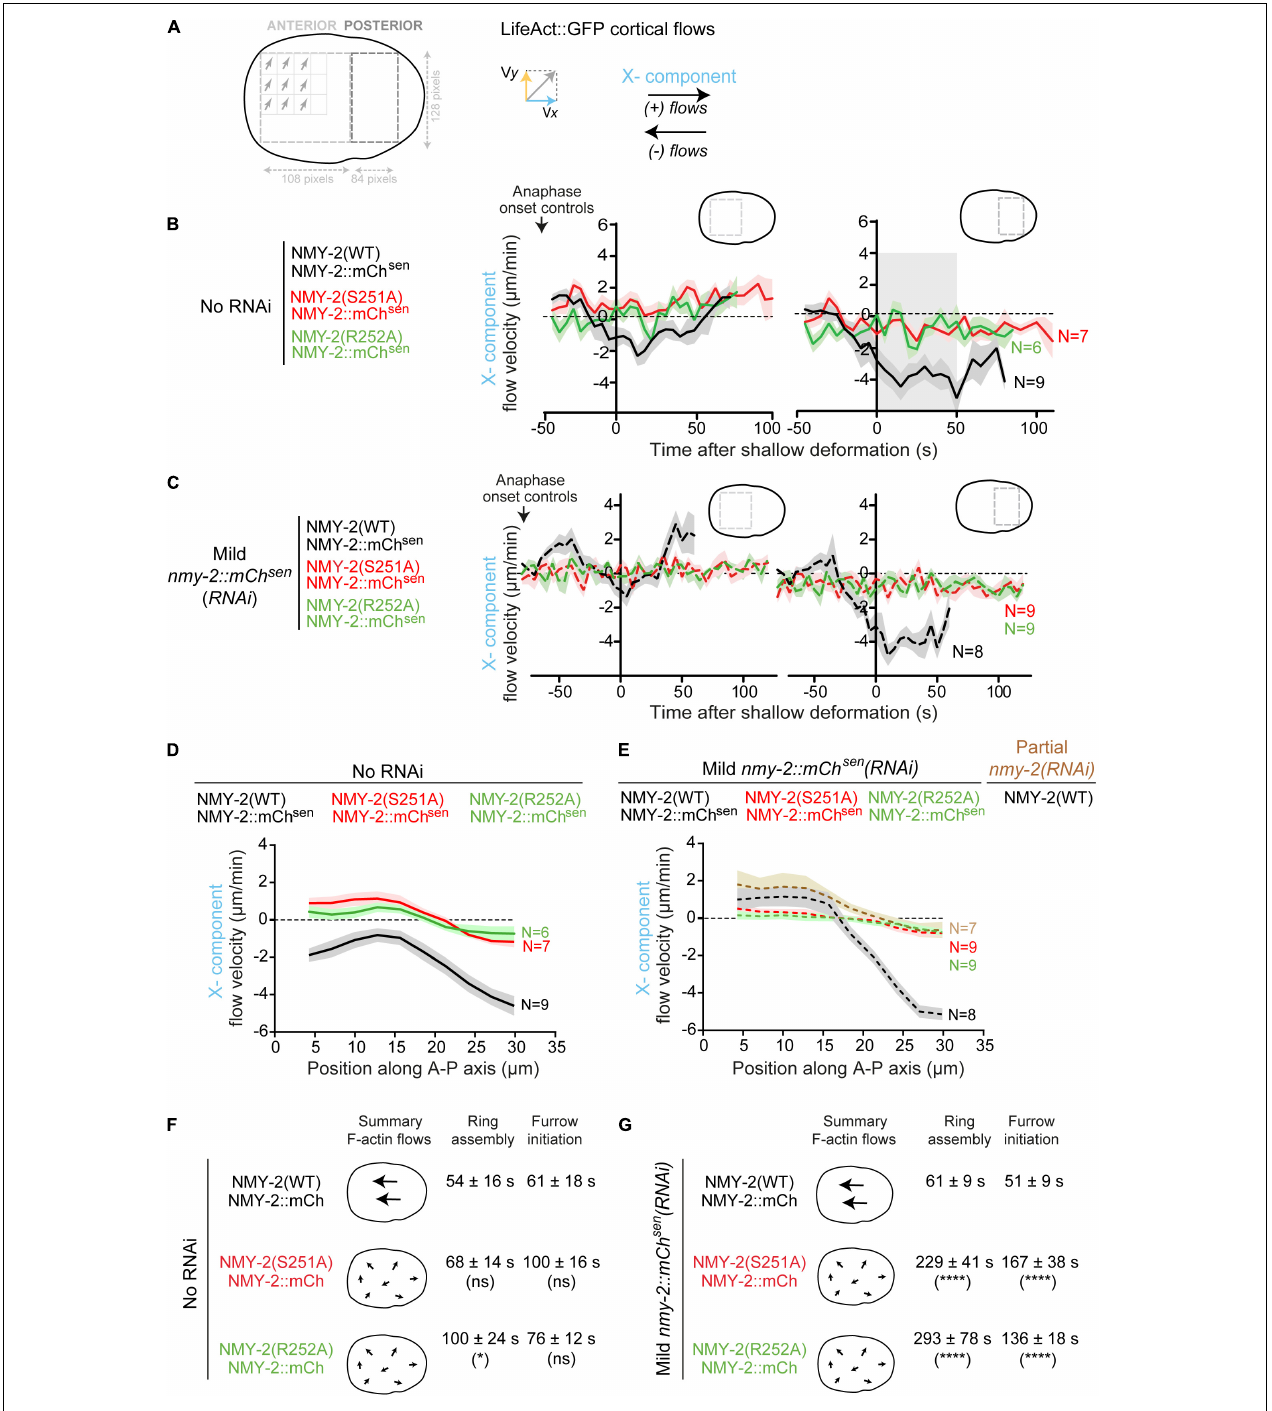
FIGURE 2 | Contractile rings assemble and cytokinesis completes in a timely manner when long-range cortical actin flows are drastically reduced. (A) Schematic illustrating how cortical LifeAct::GFP flows were analyzed by particle image velocimetry (PIV; see more details in “Materials and Methods” section). (B,C) Longitudinal (X-component) flow velocity (mean ± SEM) over time in the anterior or posterior half of embryos. Curves were aligned to the time of shallow deformation. N is the number of embryos analyzed. Period of consistently strong, posterior-anterior directed flows is indicated in gray. (D,E) Longitudinal (X-component) velocity profiles of Lifeact::GFP cortical flows along anterior-posterior (A-P) axis averaged for a period of 50 seconds starting at shallow deformation. Flow profiles show mean X-component velocity ± SEM. N is the number of embryos analyzed. (F,G) The schematic on the left summarizes overall flow intensity and directionality (X-component). Ring assembly and furrow initiation time intervals (mean ± SD) are indicated. Statistical significance in (D), (E) was determined using two-way ANOVA for repeated measures, and in (F), (G) using one-way ANOVA followed by Bonferroni’s multiple comparison test; * P < 0.05, **** P < 0.0001, ns, not significant.